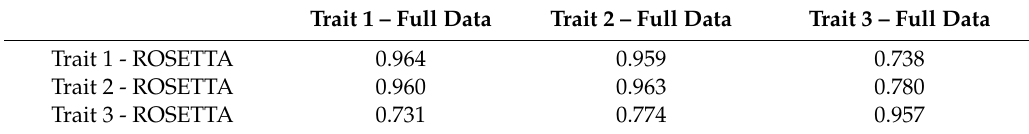
Table 5. Study 2: Expected Correlations Between Measures as Determined by Full Table 4. Study 2: Observed Correlations between ROSETTA and Full Data.